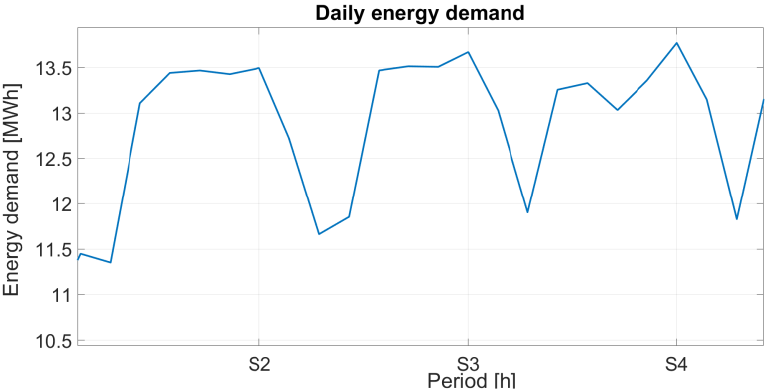
Figure 8. Stationary for the daily energy demand series between 5 January 2018 and 8 February 2018.